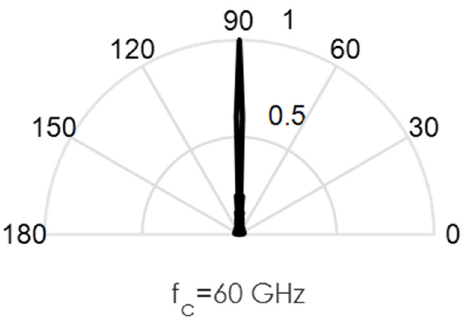
Figure 6. Directional beams produced by uniform linear arrays (ULA) operating at 60 GHz; 40 array elements with λ /2-spacing; 40 × 1 steering vector A = [1 1 1 … 1].